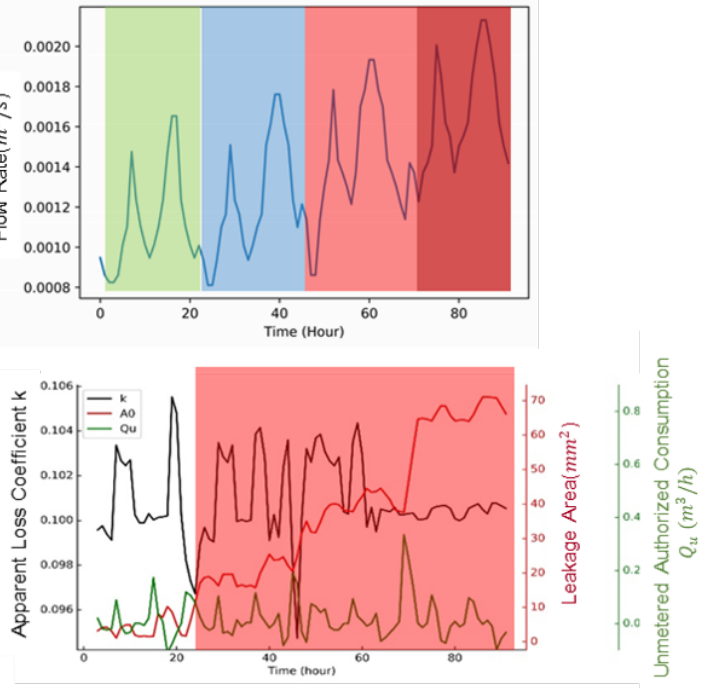
Figure 13. Results of parameters estimation at different opening degrees of valve